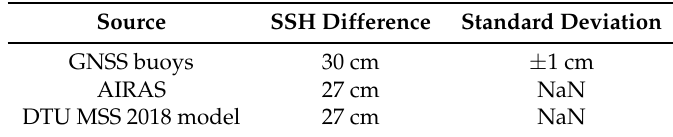
Table 2. The Cal/Val result of relative SSH difference of the AIRAS. The SSH difference was estimated between GNSS buoy 1 and buoy 2, which were 9 km